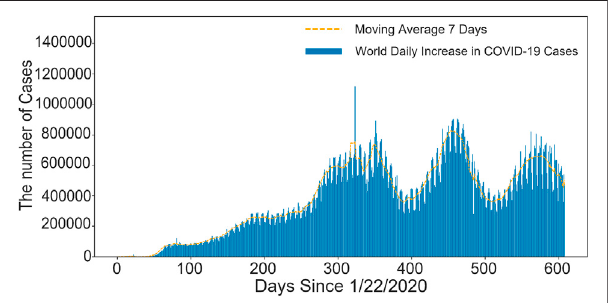
FIGURE 1 | The number of new con fi rmed cases worldwide every day. The abscissa is the timeline and the ordinate is the number of COVID-19 con fi rmed cases. The number of COVID-19 cases is increasing in the fi rst 300 days, and there is a wavy line in the second 300 days.